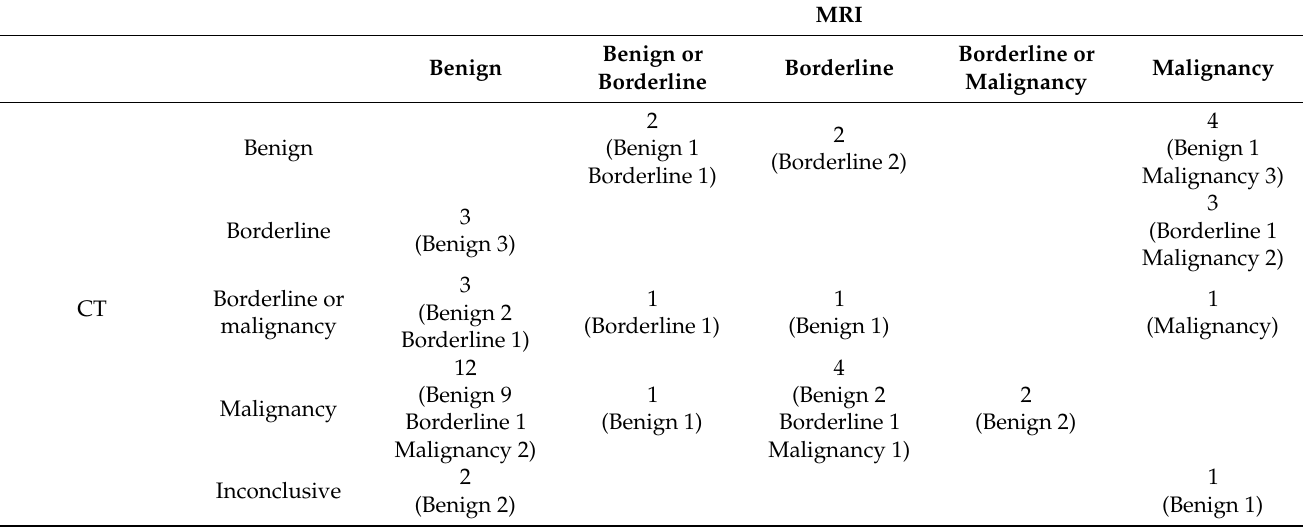
Table 4. Case review in the interpretation of prediction discrepancy between CT and